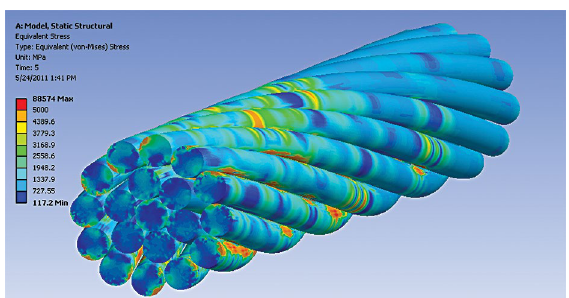
Fig. 9. Von Mises stresses for bonded contact settings – linear case solution for 1 × 19 wire rope core